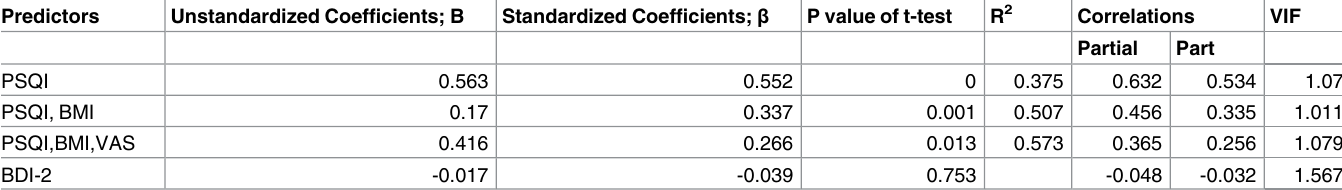
Table 4. Results of forward stepwise multiple regression analysis using General fatigue as dependent variable.